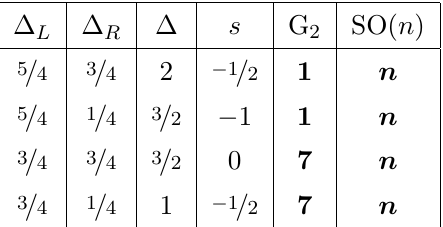
Table 20. Mass spectrum for the G(3) solution with is SO( n; 1) G 2 . (cid:2)